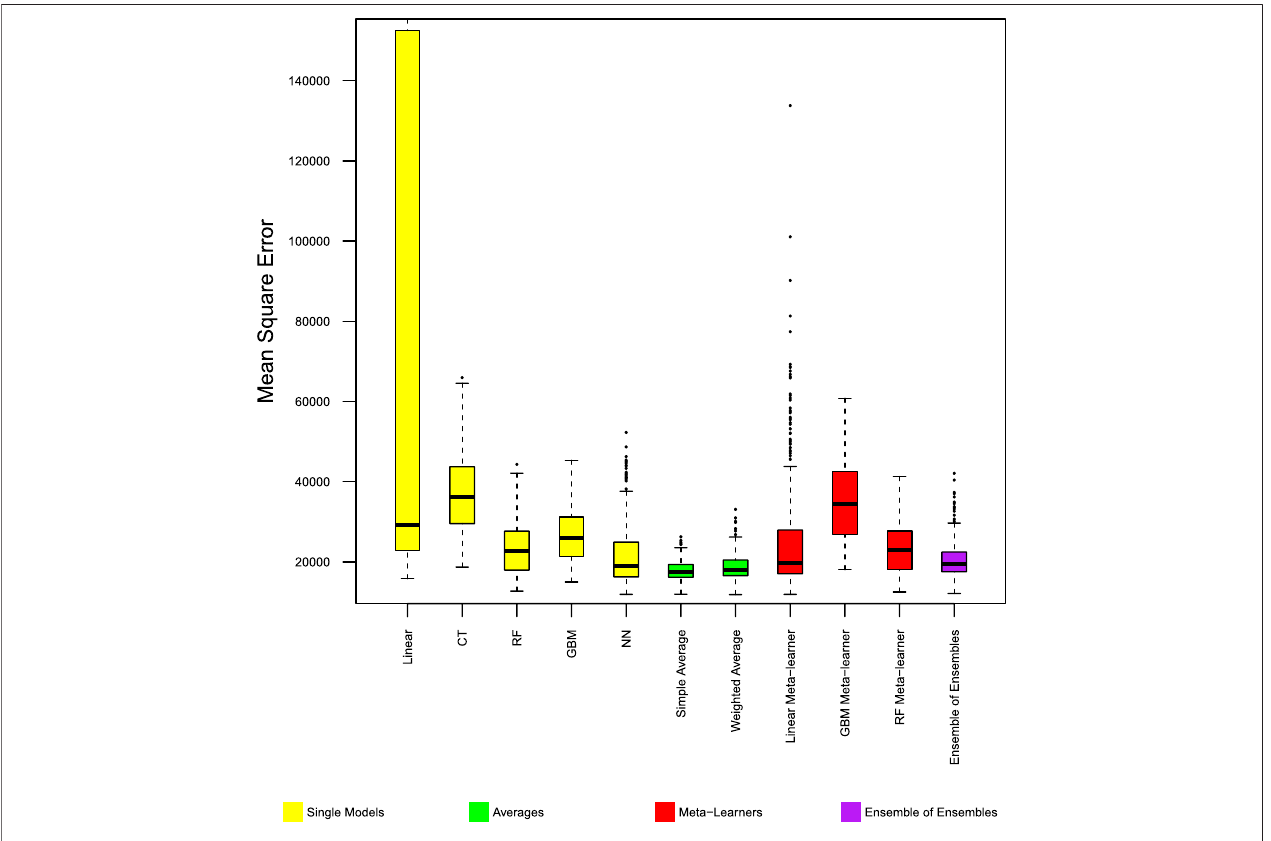
FIGURE 2 | Model performance in predicting trip production — Chicago MSE. Distribution of mean square error from 400 experiments. Boxes span 25th to 75th percentile, whiskers extend to max/min of the values, excluding outliers (1.5 box heights away from box edges, which are shown as